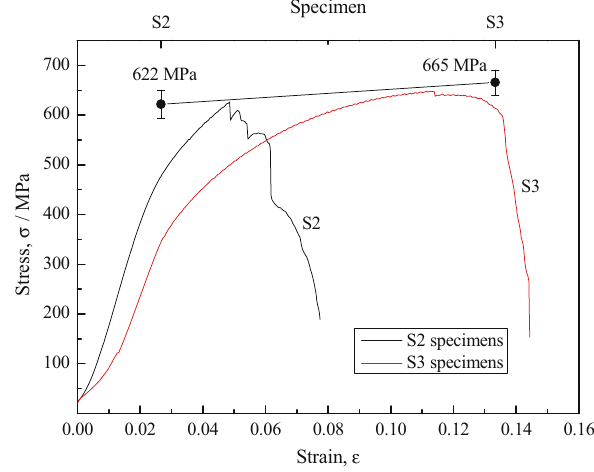
Figure 14: Dependence of stress varying with strain for the S2 and S3 specimens.